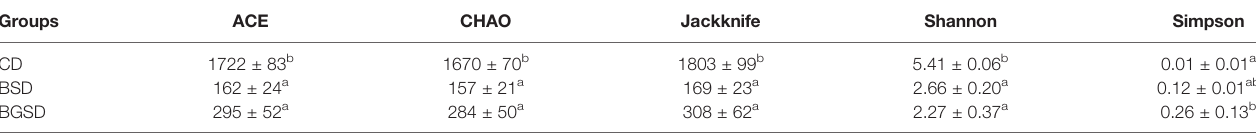
TABLE 5 | Alpha diversity of the intestinal bacterial communities of red sea bream ( Pagrus major ). Groups